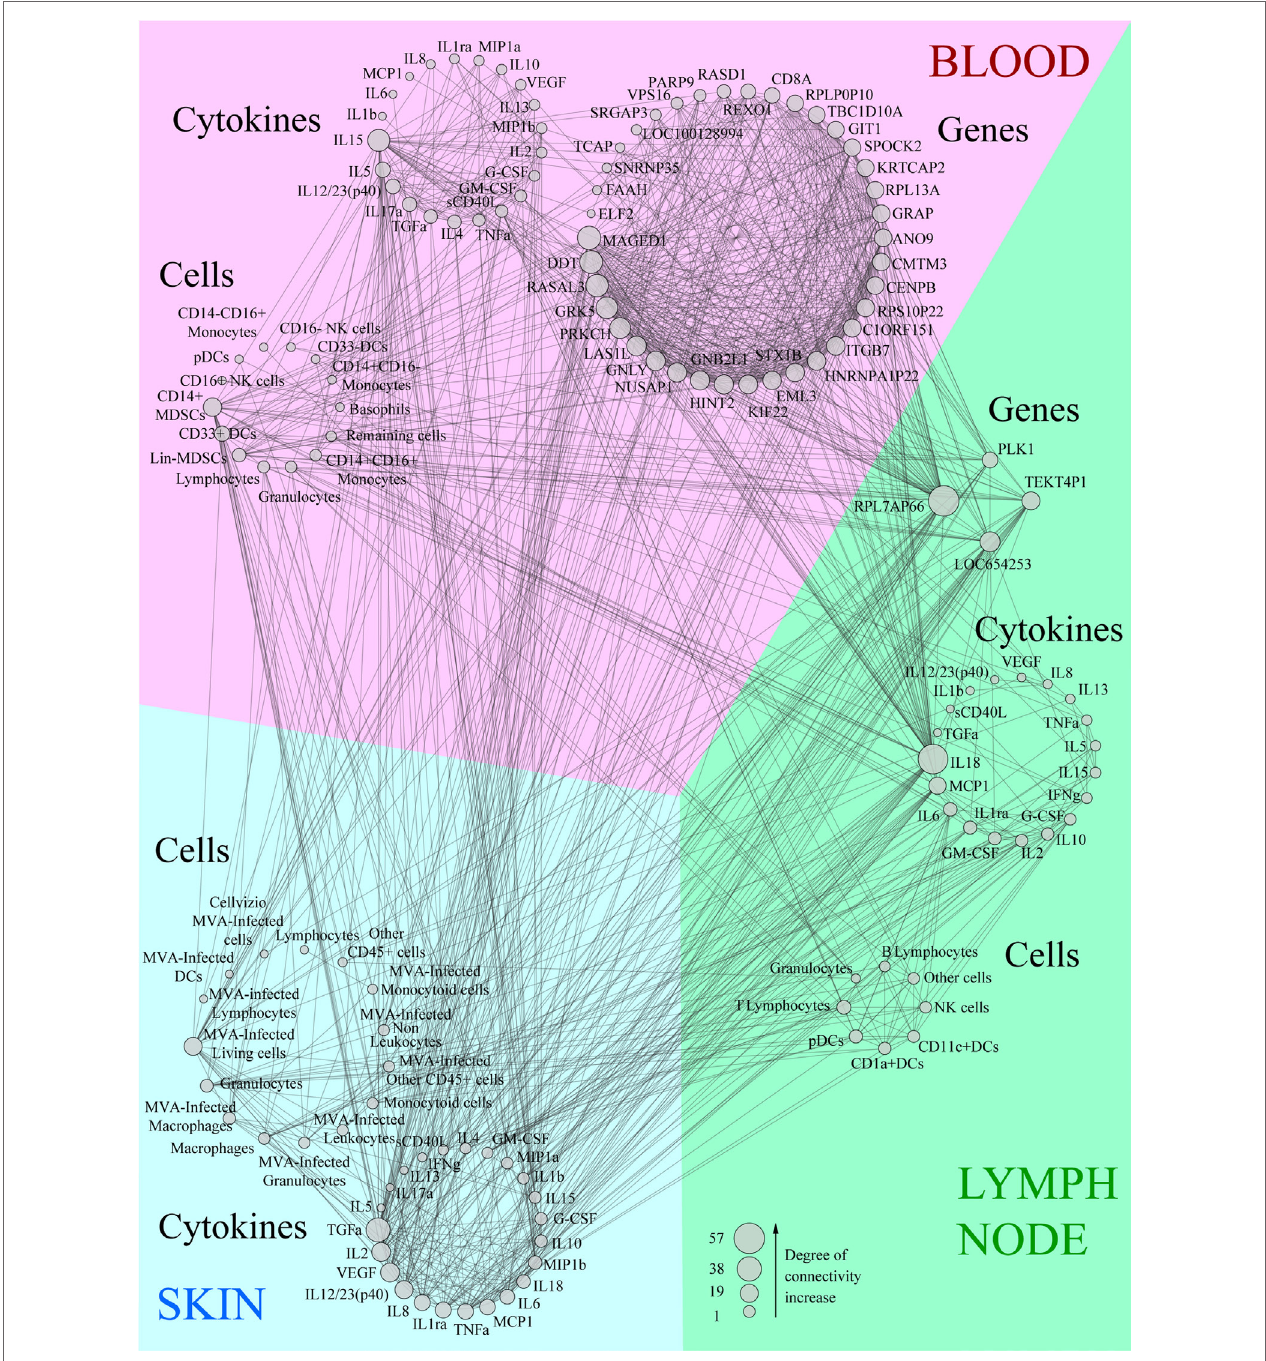
FigUre 6 | Co-expression network showing the correlations between each biological variable evaluated. Data were sorted in groups depending on the compartment (blood, lymph node, or skin) and type (cytokine, cell, or gene). Variables were then sorted depending on their size which is proportional to the number of correlations (degree of connectivity) they establish. All lines linking two parameters correspond to significant correlations between these variables (| R | > 0.8, q -value <